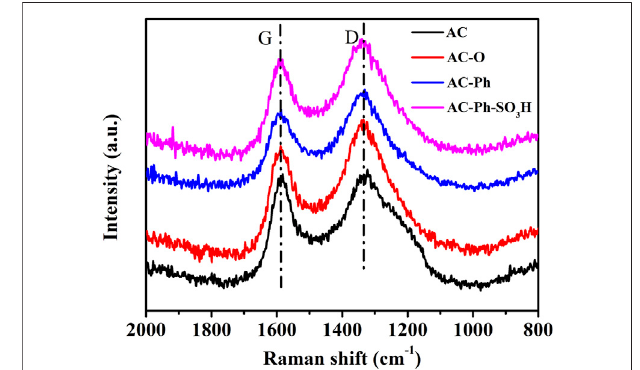
FIGURE 4 | Raman spectrum of AC, AC-O, AC-Ph and AC-Ph-SO 3 H.